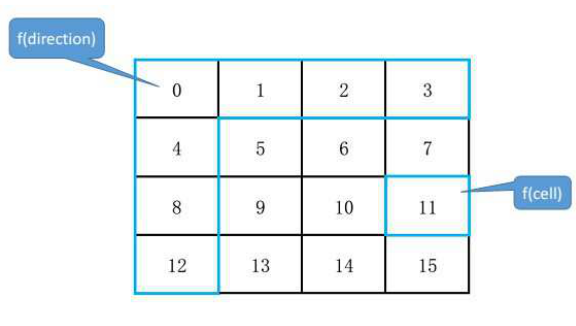
Figure 2. Schematic diagram of image segmentation